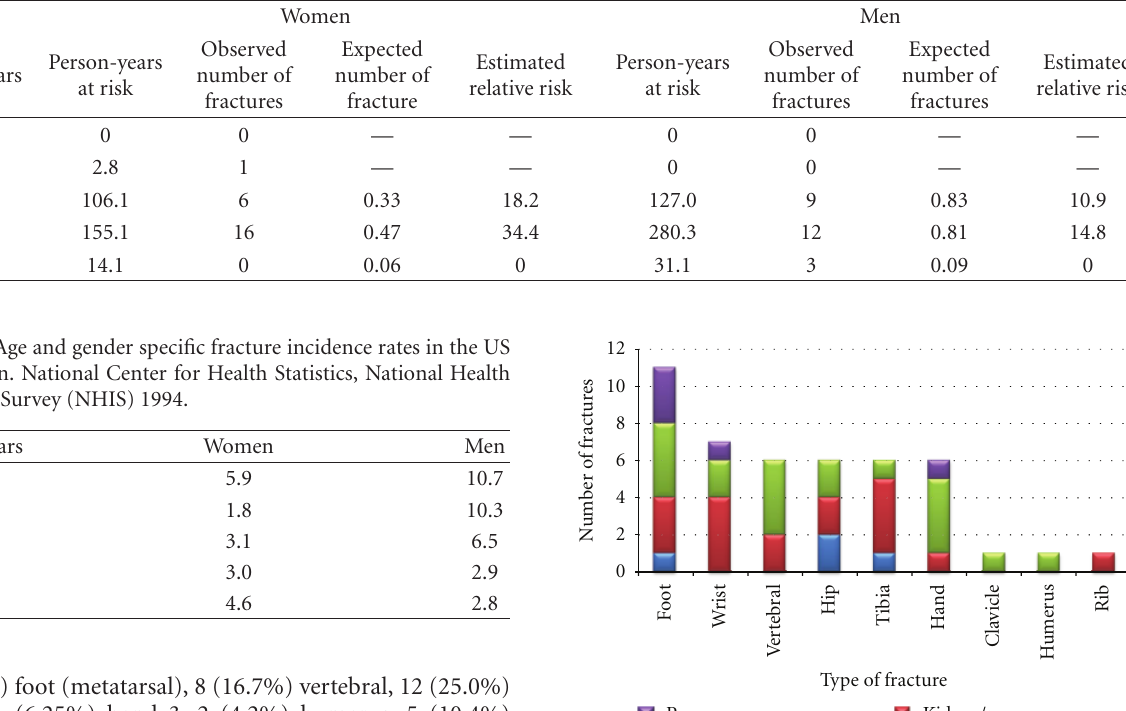
of observation for a crude fracture rate of 0.068 per year of observation. The mean age at the time of initial fracture was 48.3 ± 9.3 years, (median: 50; range: 32–63), and the mean number of months from transplant to initial fracture was 51.0 ± 23.2 months (median: 59; range: 5–80). The most common site of fracture in this group was the foot, and occurred equally in males and females 28.0% versus 31.8%, respectively. Five axial (rib and spine) fractures occurred compared with 7 limb fractures in this group as compared to 15 limb fractures. Two of the 3 patients who reported multiple fractures were